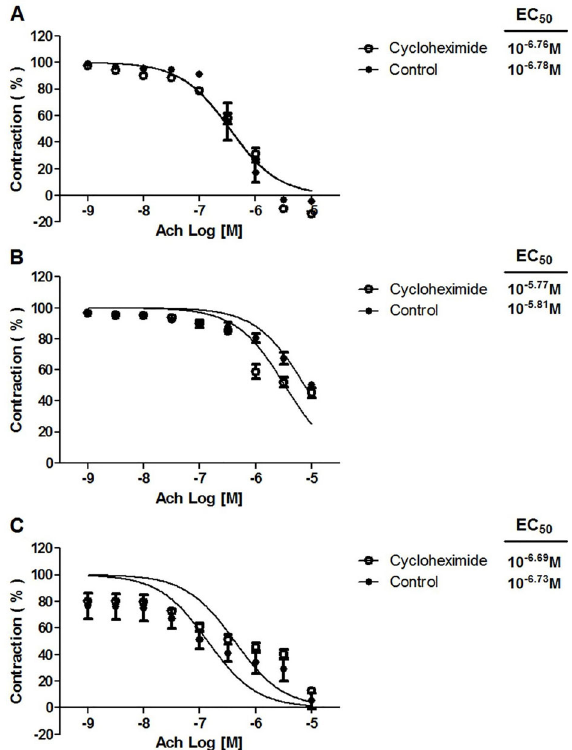
Figure 7. Effect of 10 – 5 M cycloheximide on acetylcholine (Ach) relaxation of endothelium-intact rat aortic rings precontracted with 10 – 6 M phenylephrine (PE). The rings were extracted from rats fed: A ) the standard diet; B ) the cafeteria-style (CAF)-diet; and C ) the CAF-diet plus rosuvastatin treatment. Data are reported as means ± SE of n = 6 observations. P 4 0.05 vs control (two-way